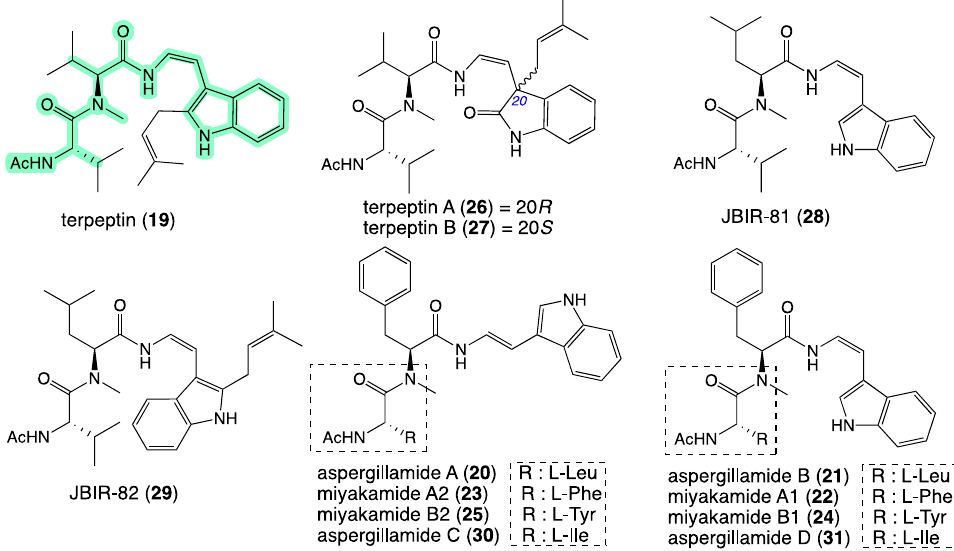
Table 2. 13 C NMR (DMSO- d 6 ) Data for aspergillamides E–F ( 7–8 ).